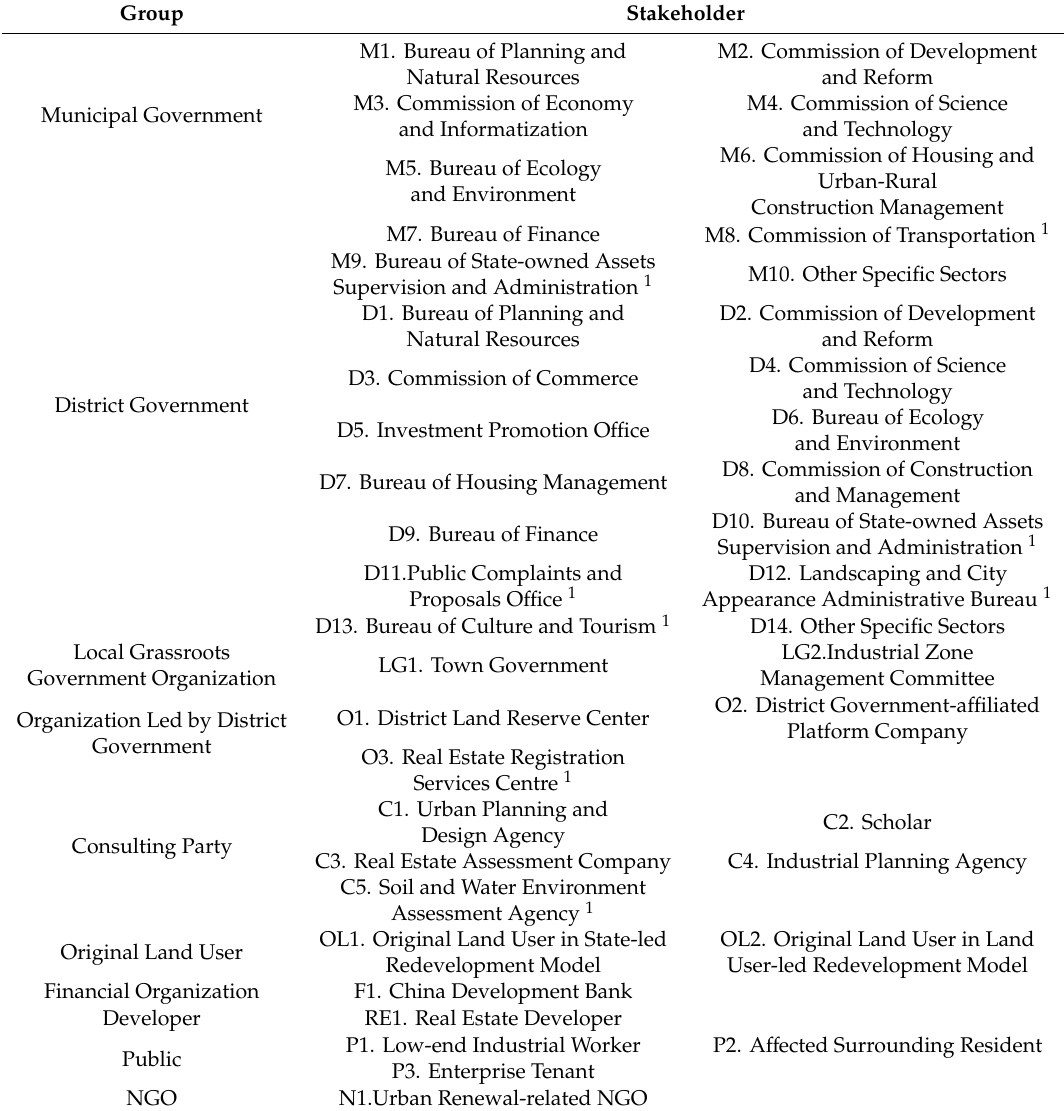
Table 2. Stakeholders and their groups in industrial land redevelopment (ILR) decision-making in Shanghai,